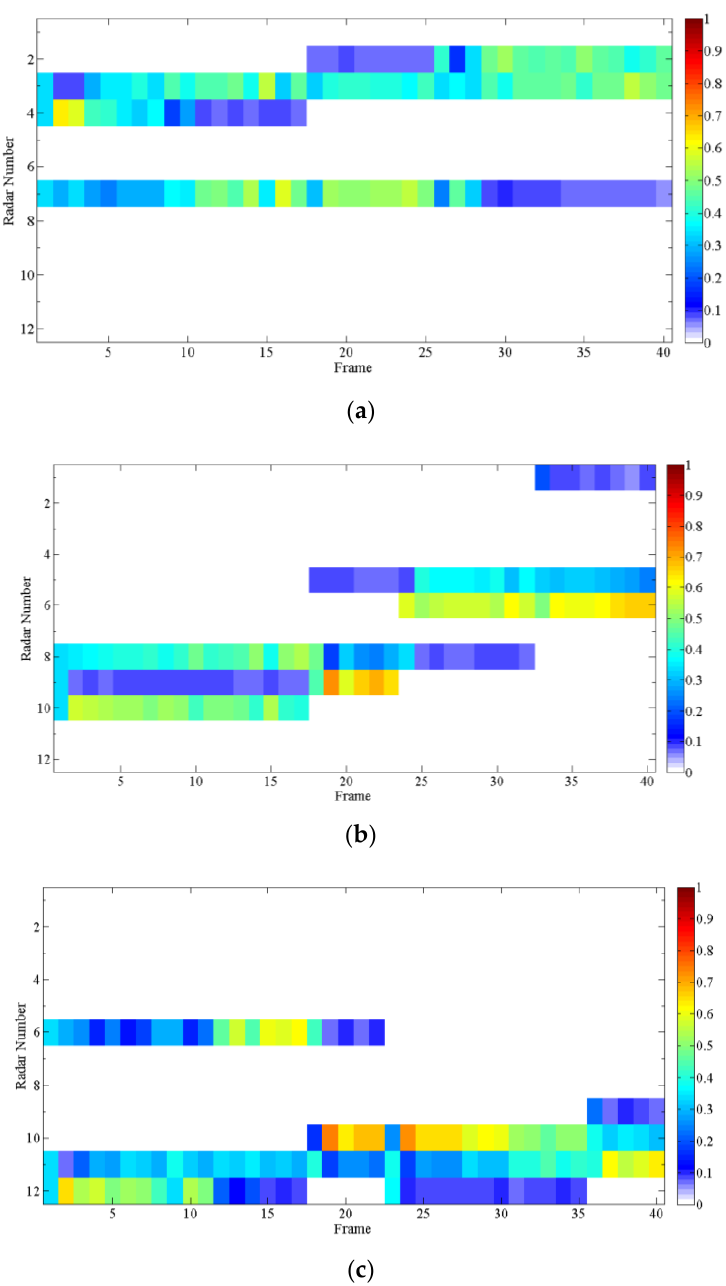
Figure 10. Percentage of radar transmitting power: ( a ) Target 1; ( b ) Target 2; ( c ) Target 3.